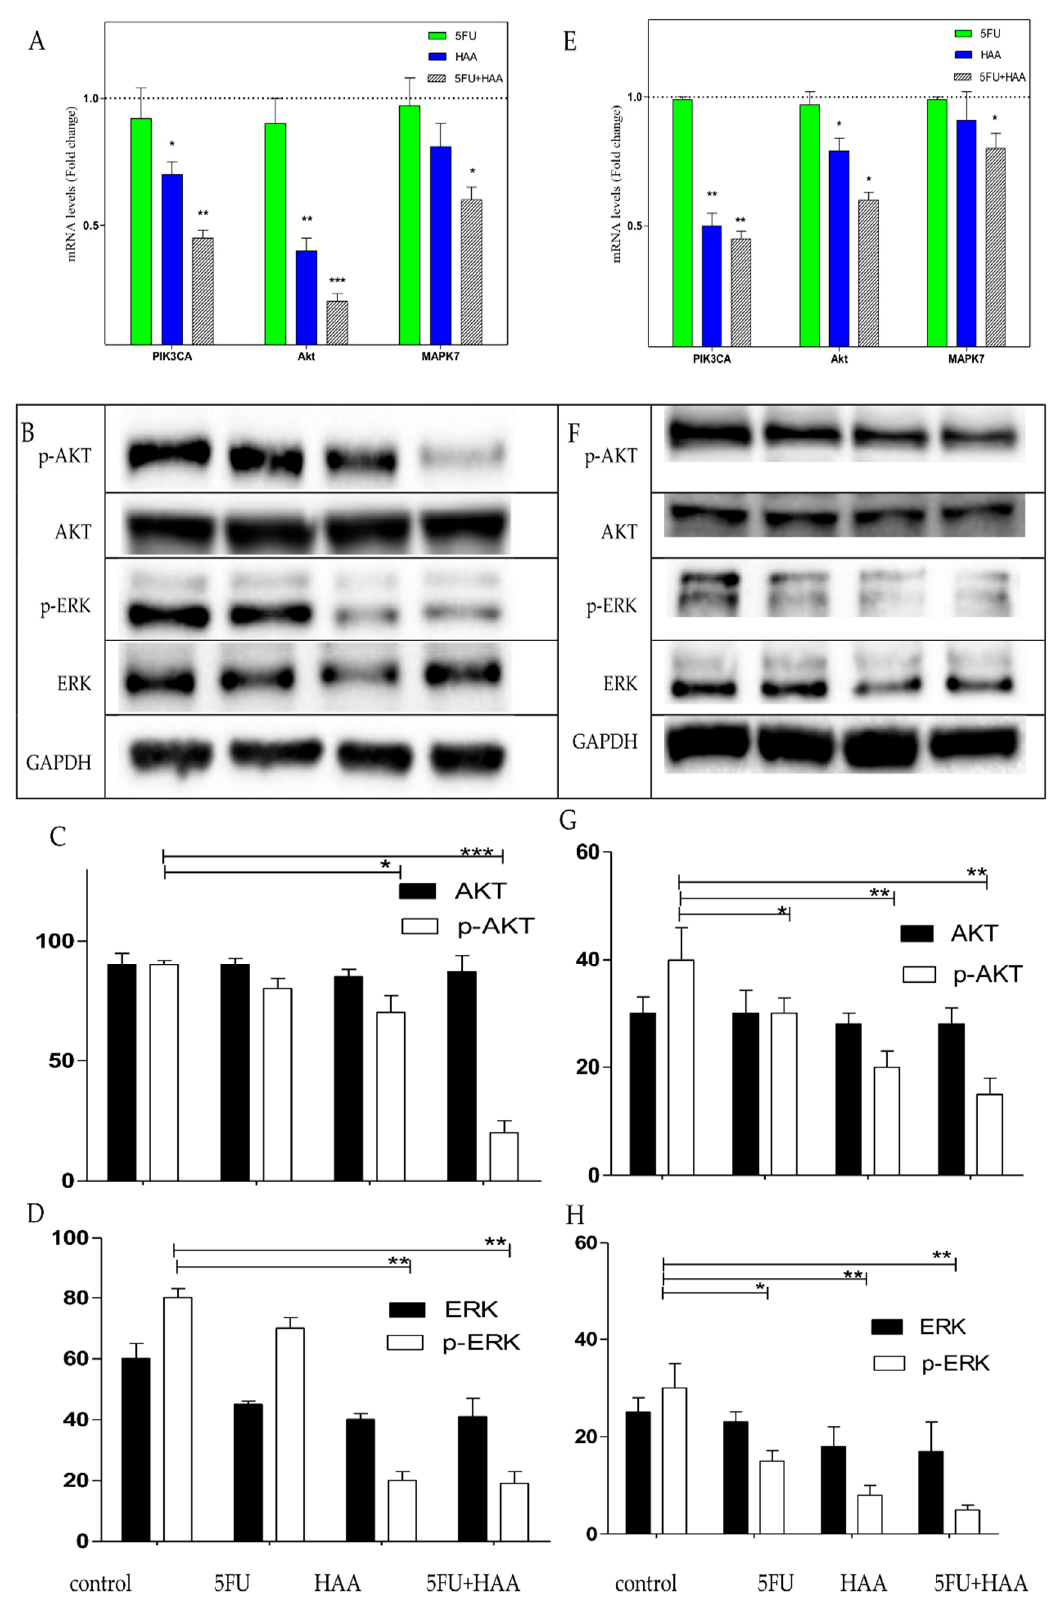
Figure 7. The expression of ( A ) PIK3CA, AKT, and MAPK7, and ( B – D ) AKT, p-AKT, ERK, and p-ERK in HT29 cells, and expression of ( E ) PIK3CA, AKT, and MAPK7, and ( F – H ): AKT, p-AKT, ERK, and p-ERK in HT29-5FU cells. All cells were treated with vehicle, 5FU (0.25 µM), HAA 2020 (3 µM), and their combination for 72 h. Results in ( A ) and ( E ) represent the mean ± SD of the mRNA fold change related to vehicle control (fold change = 1 dashed line). Results in ( C , D , G , H ) represent the mean ± SD of the fold change percentage (%, Y axis) of the relative protein levels normalized to GAPDH, n = 2, × 2 independent experiments. p < 0.05 (*), p < 0.01 (**), and p < 0.001 (***) were considered